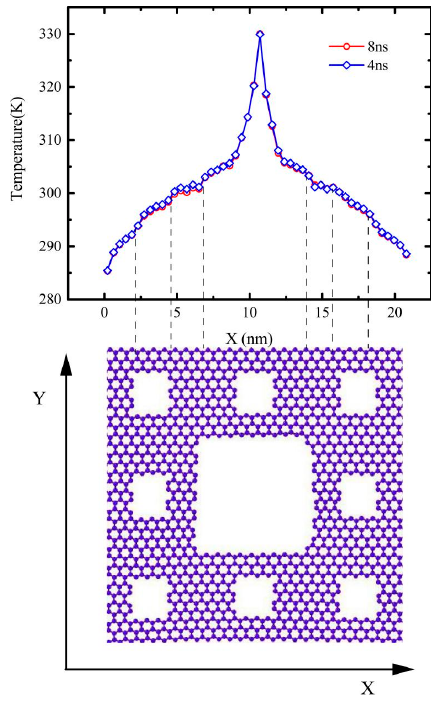
Figure 2 . The temperature profile of the gra2 running 8 ns and 4 ns in the NVE ensemble. Figure 2. The temperature profile of the gra2 running 8 ns and 4 ns in the NVE